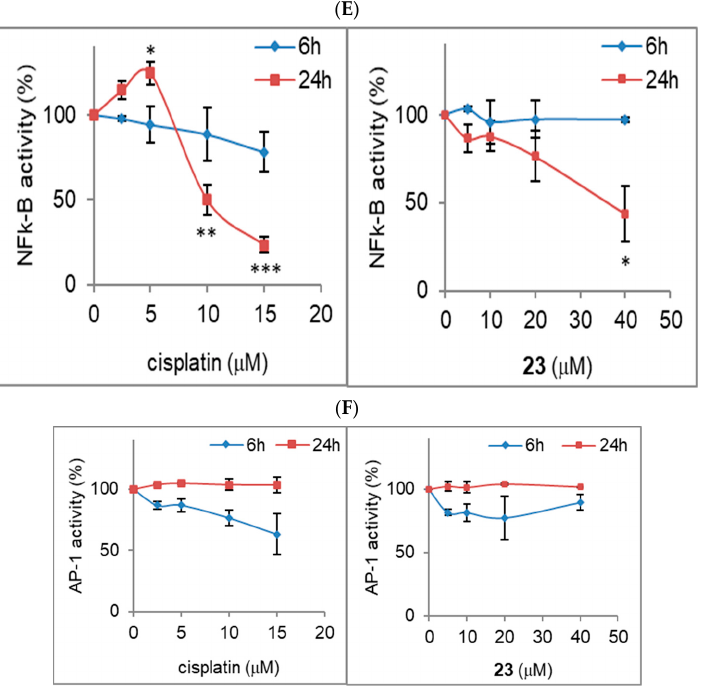
Figure 7. ( A – D ) Effect of 2 ′ derivative of adenosine modified with ferra bis(dicarbollide) (compound 23 ) and the corresponding parent sandwich ion (compound 2 ) on p53 expression levels and its phos- phorylation and acetylation in ovarian cancer cell lines. The expression of p53 was measured using the intracellular labeling method with specific antibodies for human wild type and mutant p53, clone DO-7 (p53, ( A )); p53 phosphorylated at Ser15 (p53 pS15, ( B )); p53 phosphorylated at Ser37 (p53 pS37, ( C )); and p53 acetylated in the C-terminal region at Lys382 (p53 acK382, ( D )). Intracellular labeling was performed as described in the Materials and Methods (Section 4). Data are expressed in relative fluorescence units (MFI, median fluorescence intensity) as means ± SEM values calculated for three–four independent experiments. Cells were incubated for 24 h with compounds 2 or 23 (40 μ M). DMF was used as the control (0.01%, 0.02%, or 0.04%, not toxic, not effective on p53 protein expression level). ( E , F ) Effect of compound 23 (5–40 μ M) and cisplatin (2.5–15 μ M) on the NFk-B ( E ) and AP-1 ( F ) activity determined in stable transfected cell lines (SKOV-3 and HeLa, respectively). Cells were incubated with the compound for 6 h and 24 h. Luminescence was measured in RLU (relative luminescence units), and expressed as the percentage of control values for untreated cells. The mean ± SEM values were calculated for three independent experiments. * p < 0.05, ** p < 0.01, and *** p < 0.001, compounds versus control (Student’s t -test with Bonferroni correction for multiple comparisons).